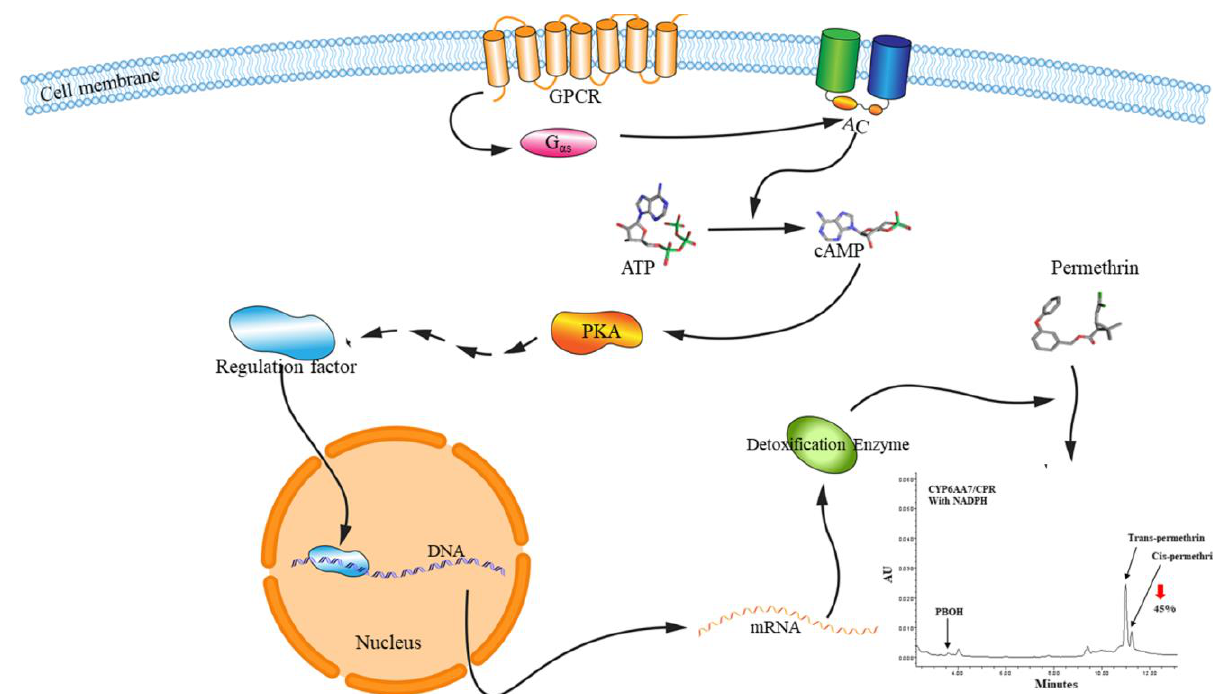
Figure 3. A hypothetical model of the G-protein-coupled receptor (GPCR) intracellular cascade in the insecticide resistance of insects, according to the hypothetical pathway constructed for GPCRs in human cells [95] and in mosquitoes [49–51]. The constitutive expressed GPCR in resistant mosquitoes activates the G-protein alpha s-subunit (G α s), which stimulates adenylate cyclase to convert ATP to cAMP. cAMP activates the protein kinase A, which is involved in the increased expression of cytochrome P450 genes [49,50], resulting in elevating the detoxification ability of insects to insecticides. Inhibitions of cAMP production or PKA activity can interrupt this regulation pathway; the decreased production of cAMP or PKA activity is strongly associated with the decreased expression of resistance-related P450 genes and increased sensitivity to insecticides in both mosquitoes [49,50].